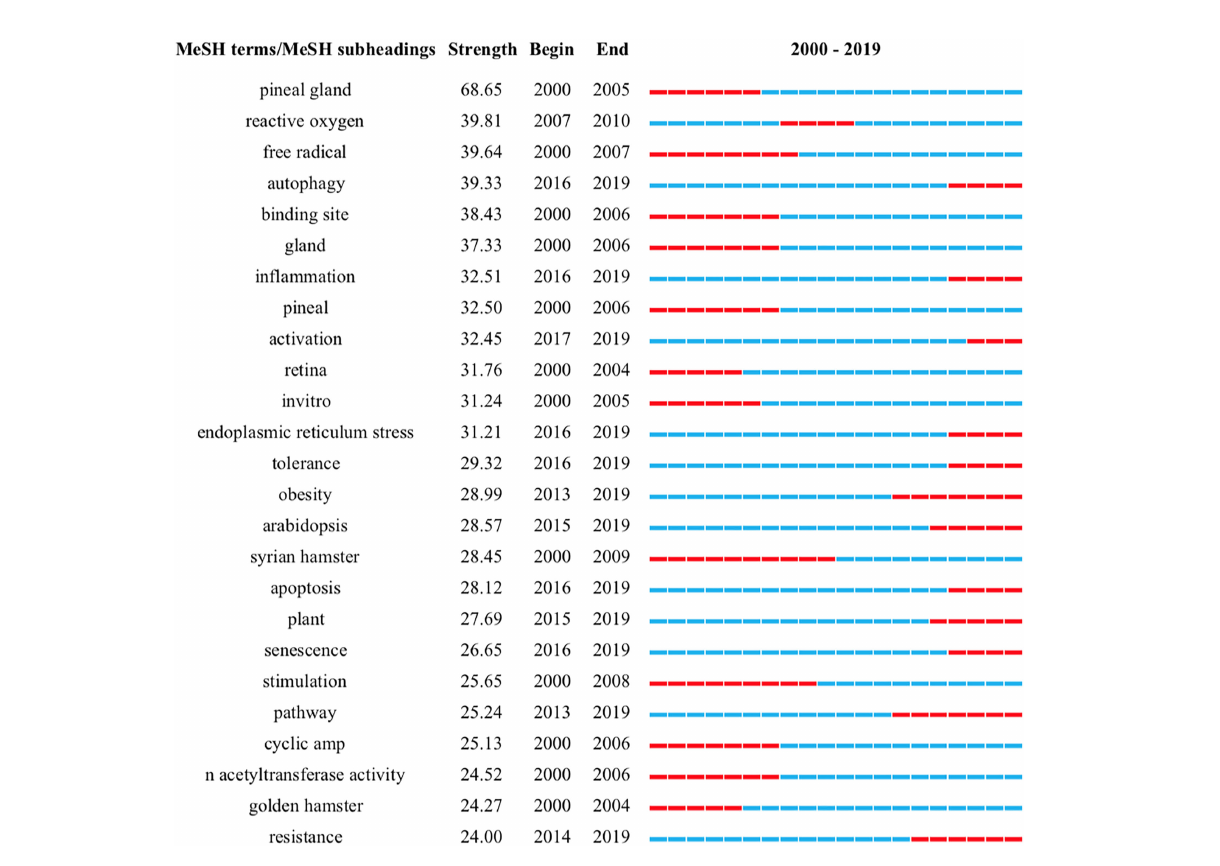
FIGURE 4 | The top 25 Mesh terms and their outbreak time (Strength re fl ects the frequency of occurrence of the